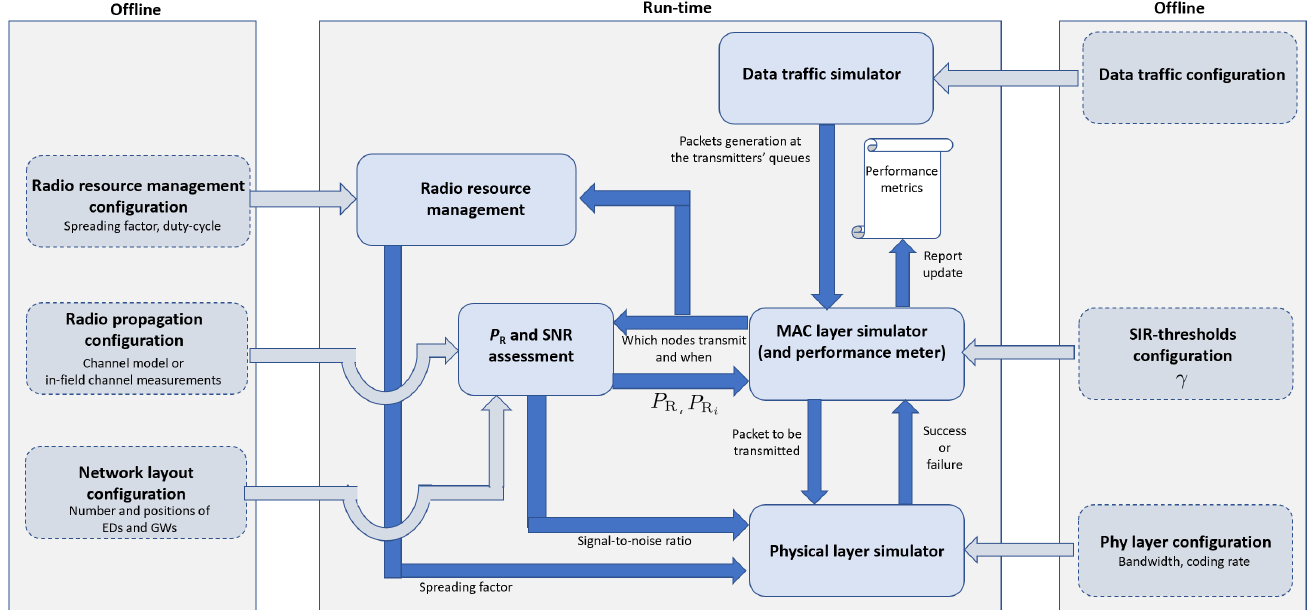
Figure 3. Simulator block